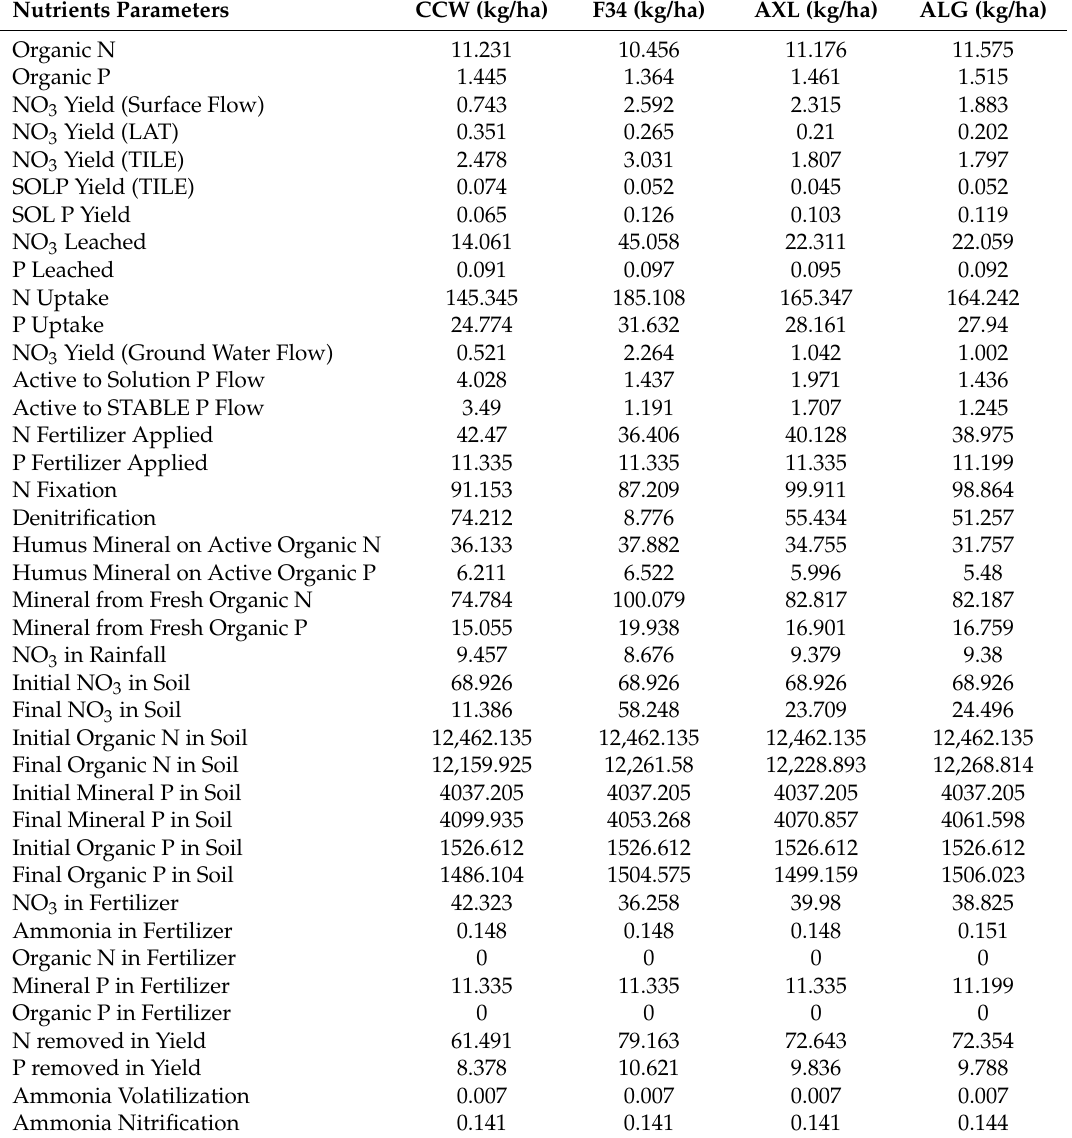
Table A2. Average annual nutrients balance for CCW, F34, AXL, and ALG